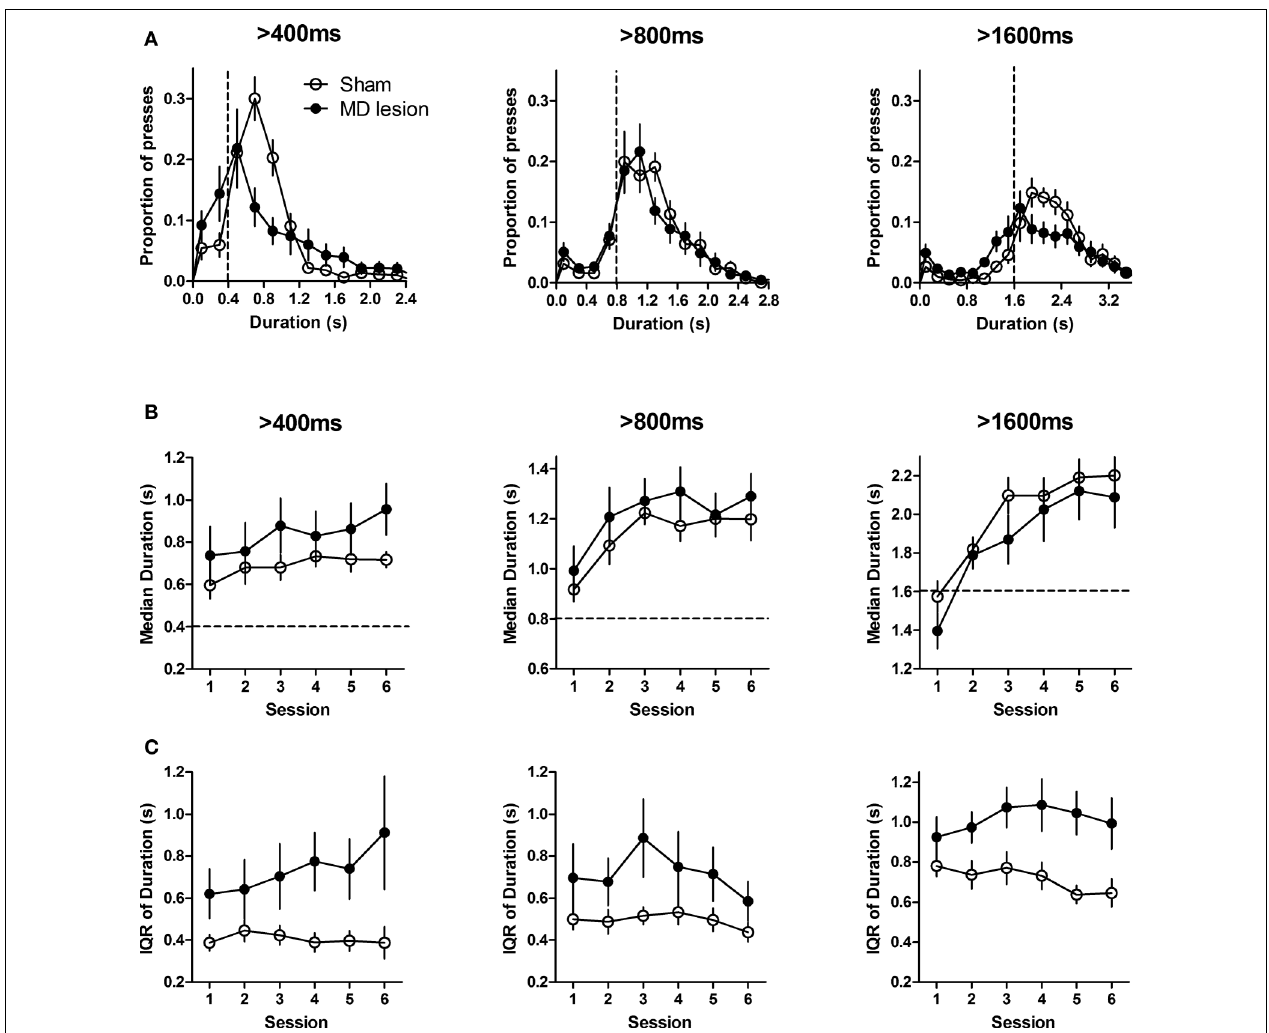
durations. (B) Median press durations. (C) Interquartile range (IQR) of duration distribution for each criterion duration across six training sessions. Error bars represent